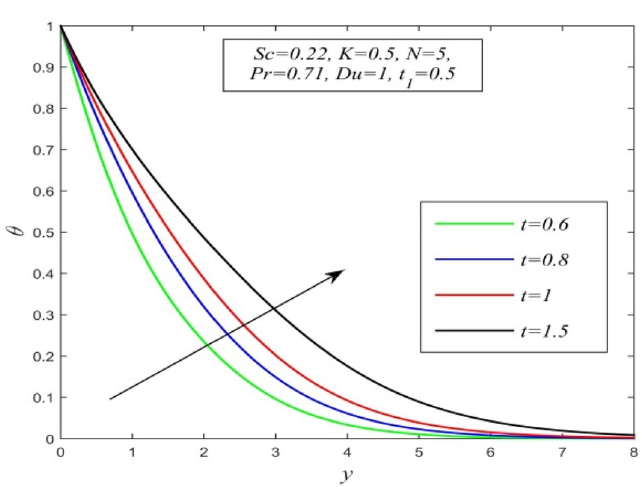
Figure 5. θ versus y for different t and Sc = 0.22, K = 0.5, N = 5, Pr = 0.71, Du = 1, t 1 = 0.5.